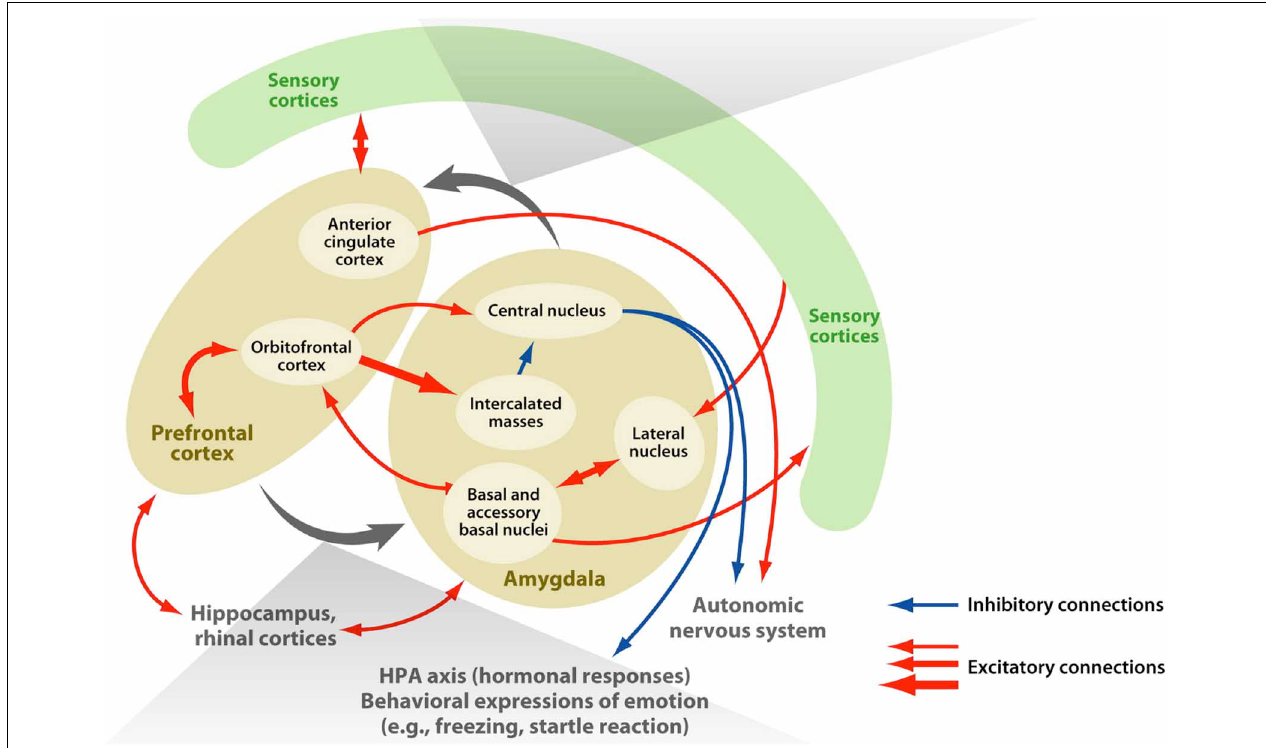
FIGURE 1 | Connectivity of the amygdala. The macaque amygdala, comprised of multiple subdivisions, has extensive connections with the frontal lobe. Adapted from Figure 1 (Salzman and Fusi, 2010).